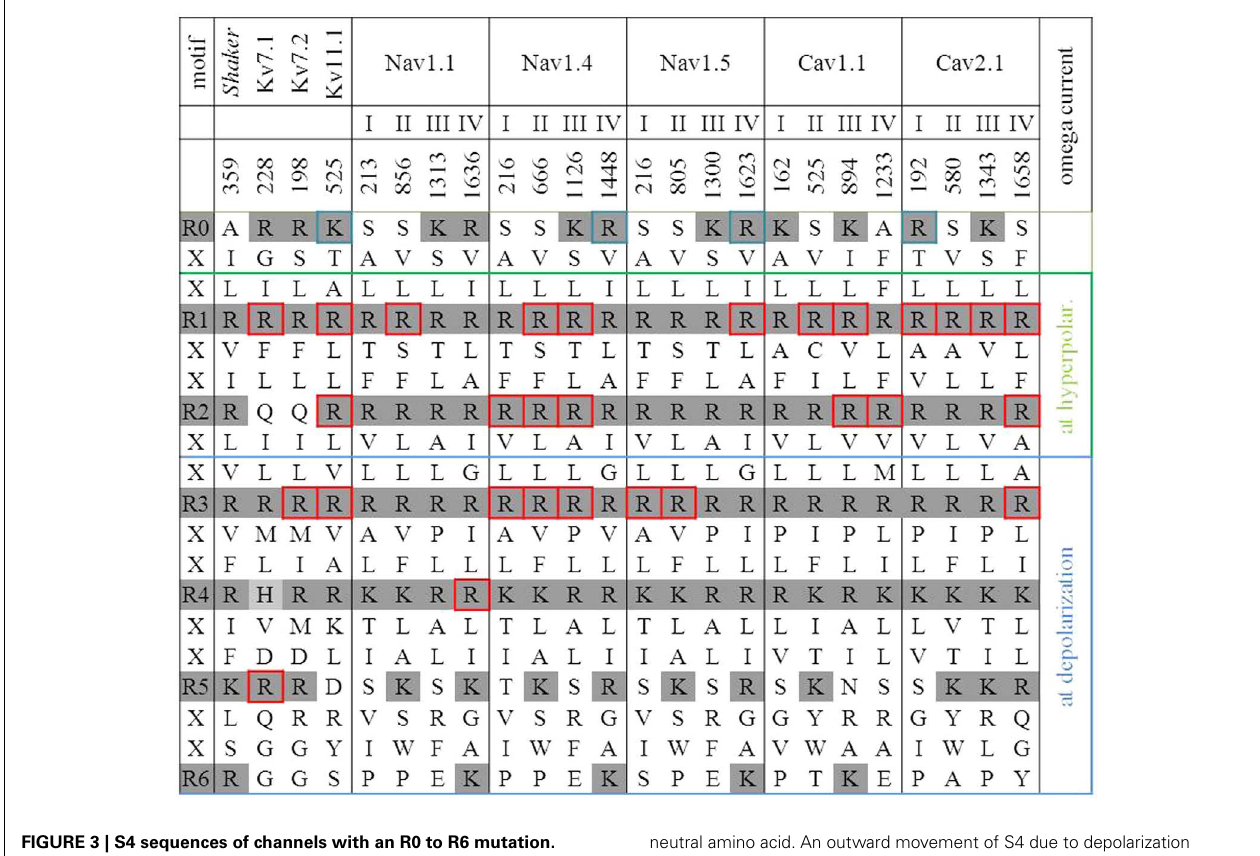
FIGURE 3 | S4 sequences of channels with an R0 to R6 mutation. Positively charged residues in R0 to R6 positions are delineated with a shaded background (gray).The constriction of the omega pore lies between R2 and R3.Therefore an inward movement of S4 due to hyperpolarization opens the omega pore if R1 or R2 is replaced by a